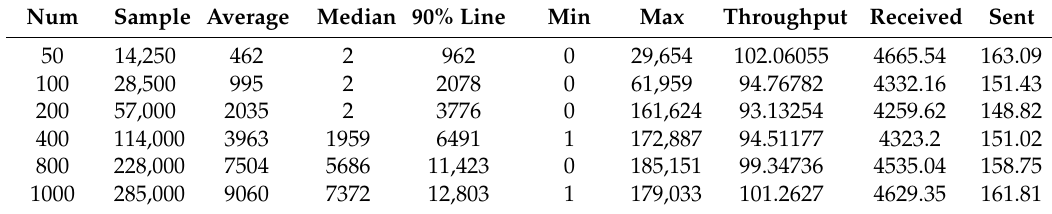
Table 6. System stress test